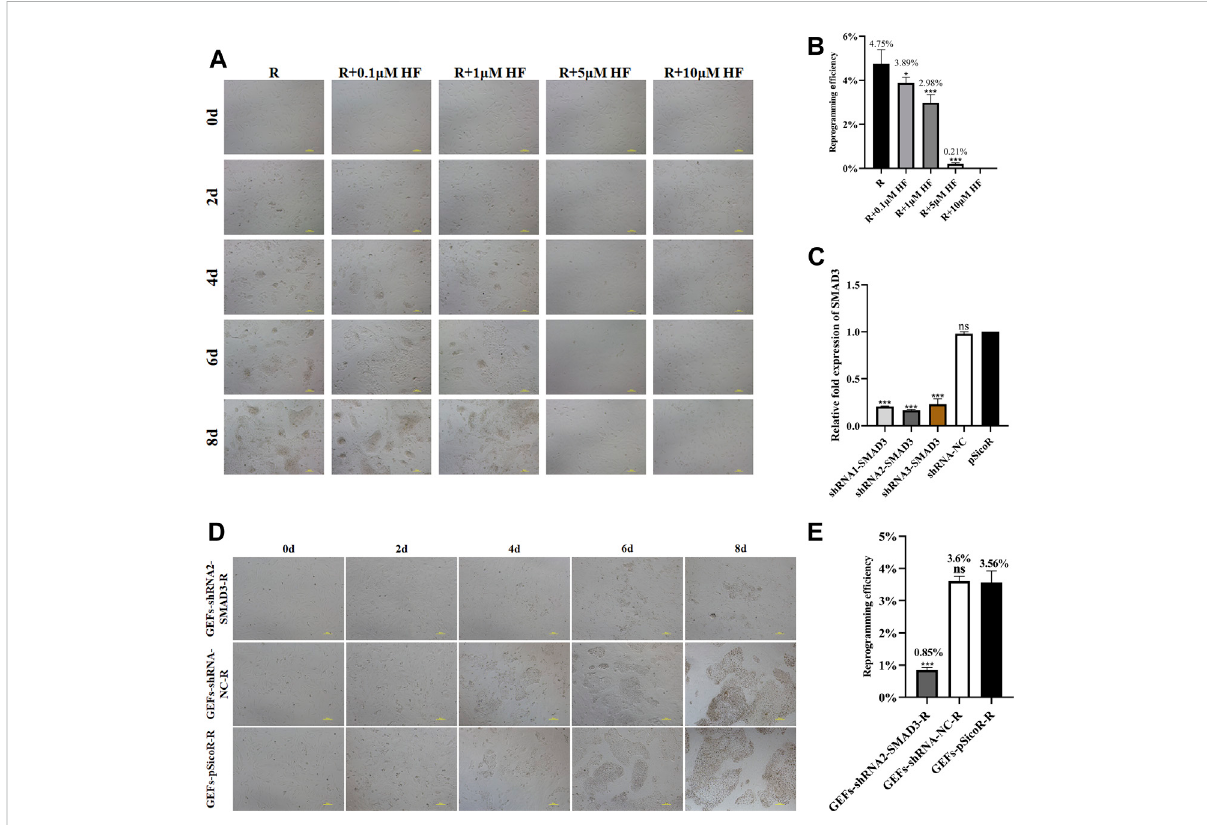
FIGURE 4 SMAD3 downregulation impedes the reprogramming process of induced mammary epithelial cells in goats. (A) Effect of different concentrationsofHFonthereprogrammingprocessofinducedmammaryepithelialcellsingoats.Scalebar,100 μ m. (B) Inhibitoryeffectofdifferent concentrationsofHFonthereprogrammingef fi ciencyofinducedmammaryepithelialcellsingoats. n =3biologicalreplicates.Dataarerepresented as the mean ± SEM. * p < 0.05, *** p < 0.001 (one-way ANOVA). (C) Expression levels of SMAD3 gene in three interfering targetsequences in the corresponding cell lines (GEFs-shRNA1/2/3-SMAD3). n = 3 biological replicates. Data are represented as the mean ± SEM. *** p < 0.001 (one-way ANOVA). (D) Effect of interfering with SMAD3 expression on the reprogramming process of induced mammary epithelial cells in goats. Scale bar, 100 μ m. (E) Interfering with SMAD3 expression signi fi cantly reduces the reprogramming ef fi ciency of induced mammary epithelial cells in goats. Scale bar, 100 μ m; n = 3 biological replicates. Data are represented as the mean ± SEM. *** p < 0.001 (one-way